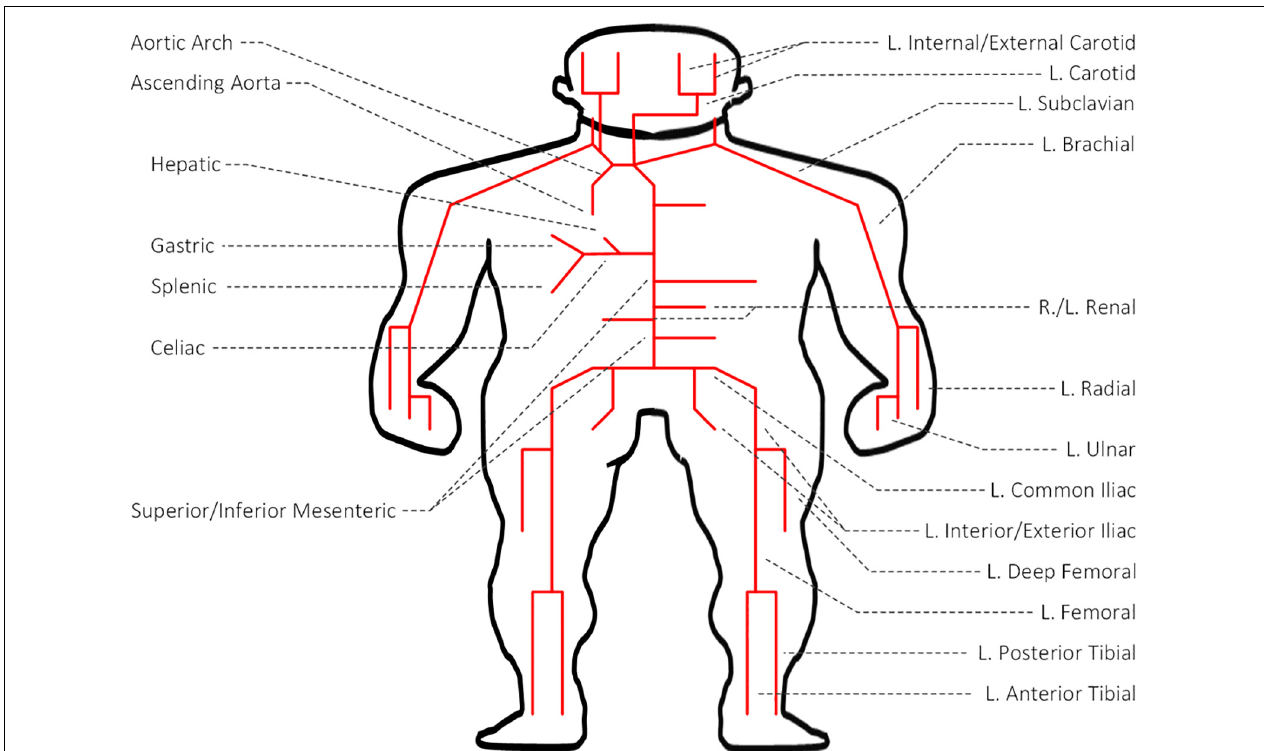
FIGURE 1 | Transmission line (TL) model of arterial hemodynamics consisting of 55 TLs, each of which represents an arterial segment characterized by segment-specific viscous, elastic, and inertial